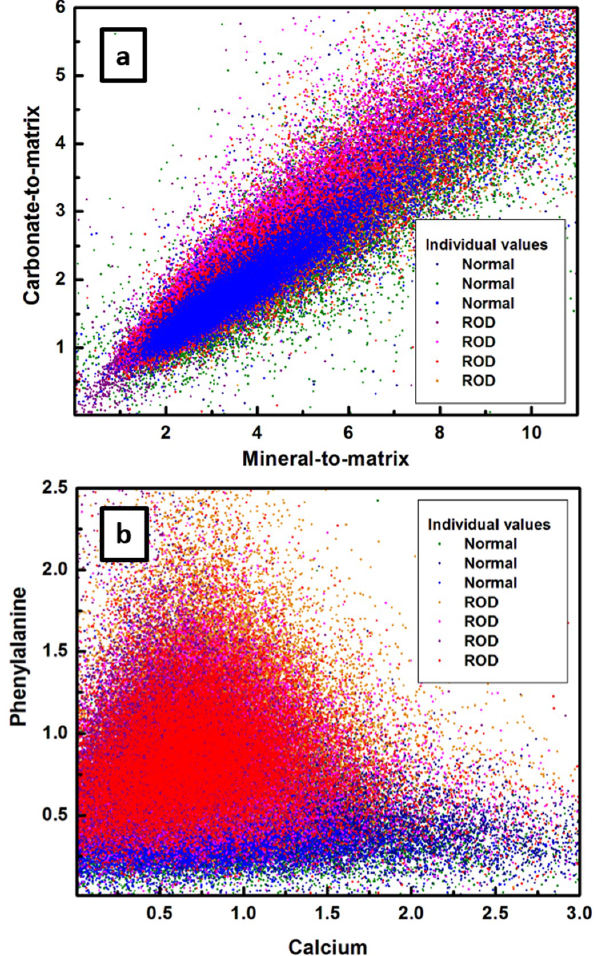
Figure 3. Representation of ( a ) the carbonate-to-matrix biomarker ( ν 1 CO 3 2 − / amide I) versus the mineral-to-matrix biomarker ( ν 1 PO 4 3 / amide I), and ( b ) the phenylalanine content (phenylalanine / amide III) versus that of calcium ( ν 2 PO 4 3 /amide III) for all the 22,500 independent Raman spectra measured per sample. A similar color labeling as in Figure 1 was used for each of the 7 bone samples.